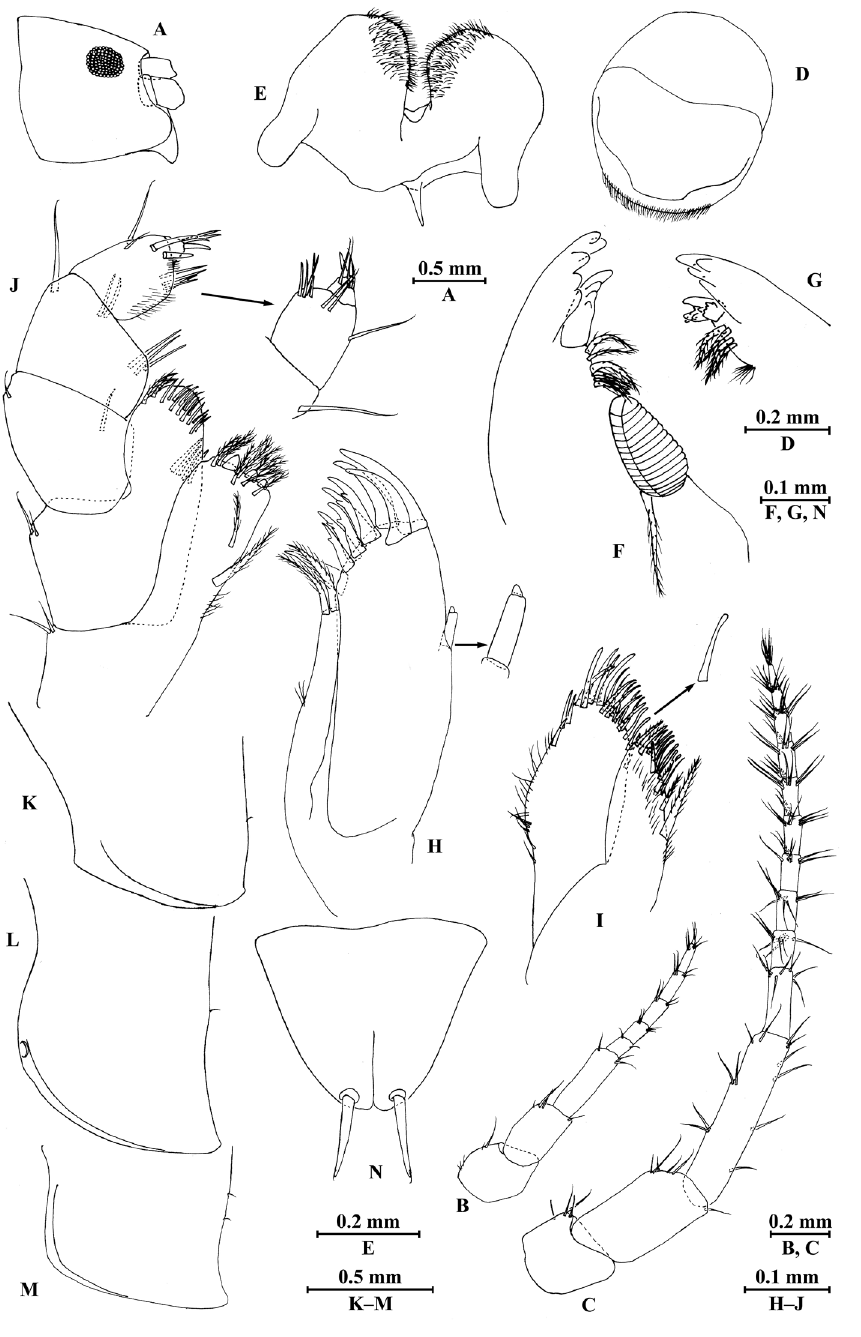
Figure 2. Myanmarorchestia peterjaegeri Hou, sp. n., female holotype. A head B antenna I C antenna II D upper lip E lower lip F left mandible G incisor of right mandible H left maxilla I I maxilla II J maxil- liped K epimeral plate I L epimeral plate II M epimeral plate III N